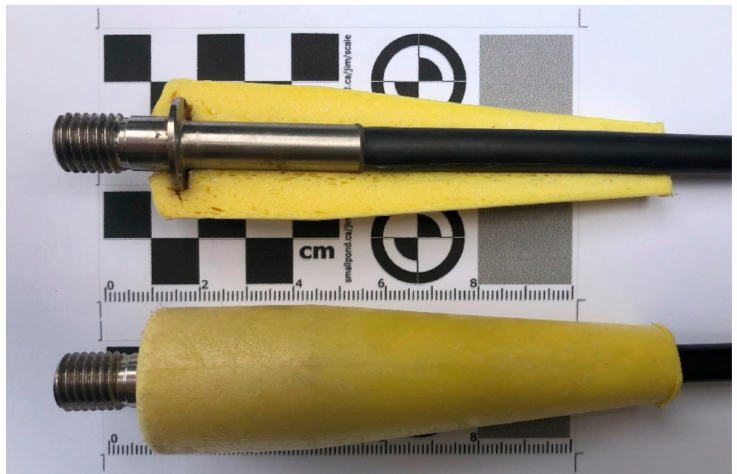
Figure 1. Sampling ends of some darts in this study (biopsy punch not shown). A cross-section was taken of a used dart (upper), the lower dart had not yet been used for sampling. Note apparent compression of the yellow foam in the upper (previously used)